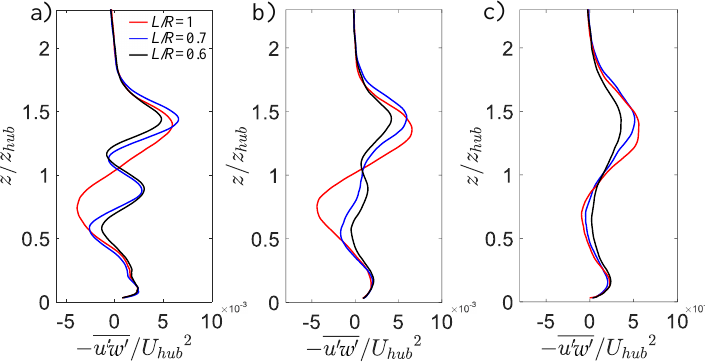
Figure 10. Profiles of the kinematic shear stress, − u (cid:48) w (cid:48) / U 2 0.7 and 1 at x / d T = ( a ) 2.6, ( b ) 3.8 and ( c )